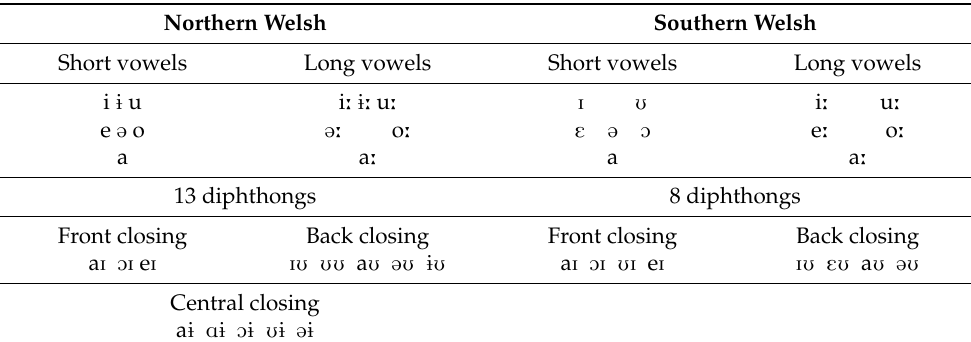
Table 1. The vowels of northern and southern Welsh. Adapted from Mayr and Davies (2011). Northern Welsh Southern